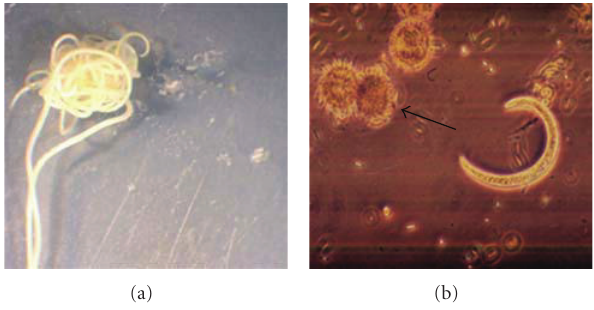
Figure 6: (a) Adults of Allomermis solenopsi forming a mating cluster and laying eggs (10x). (b) Eggs (arrow) and juvenile A. solenopsi